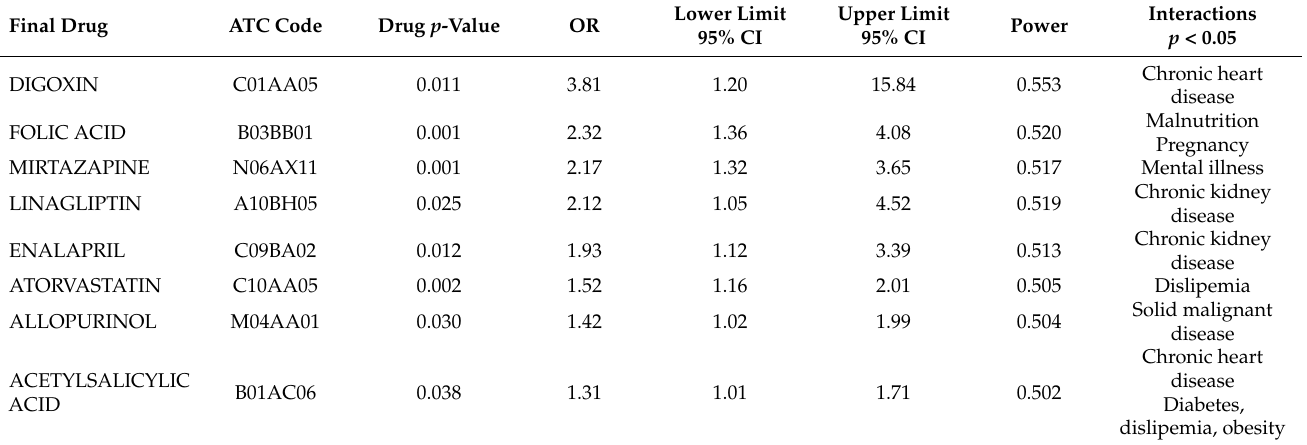
Table 3. Final drug PSM analysis. Lower and upper limits of the 95% confidence interval for the odds ratio. The final substances significantly associated with